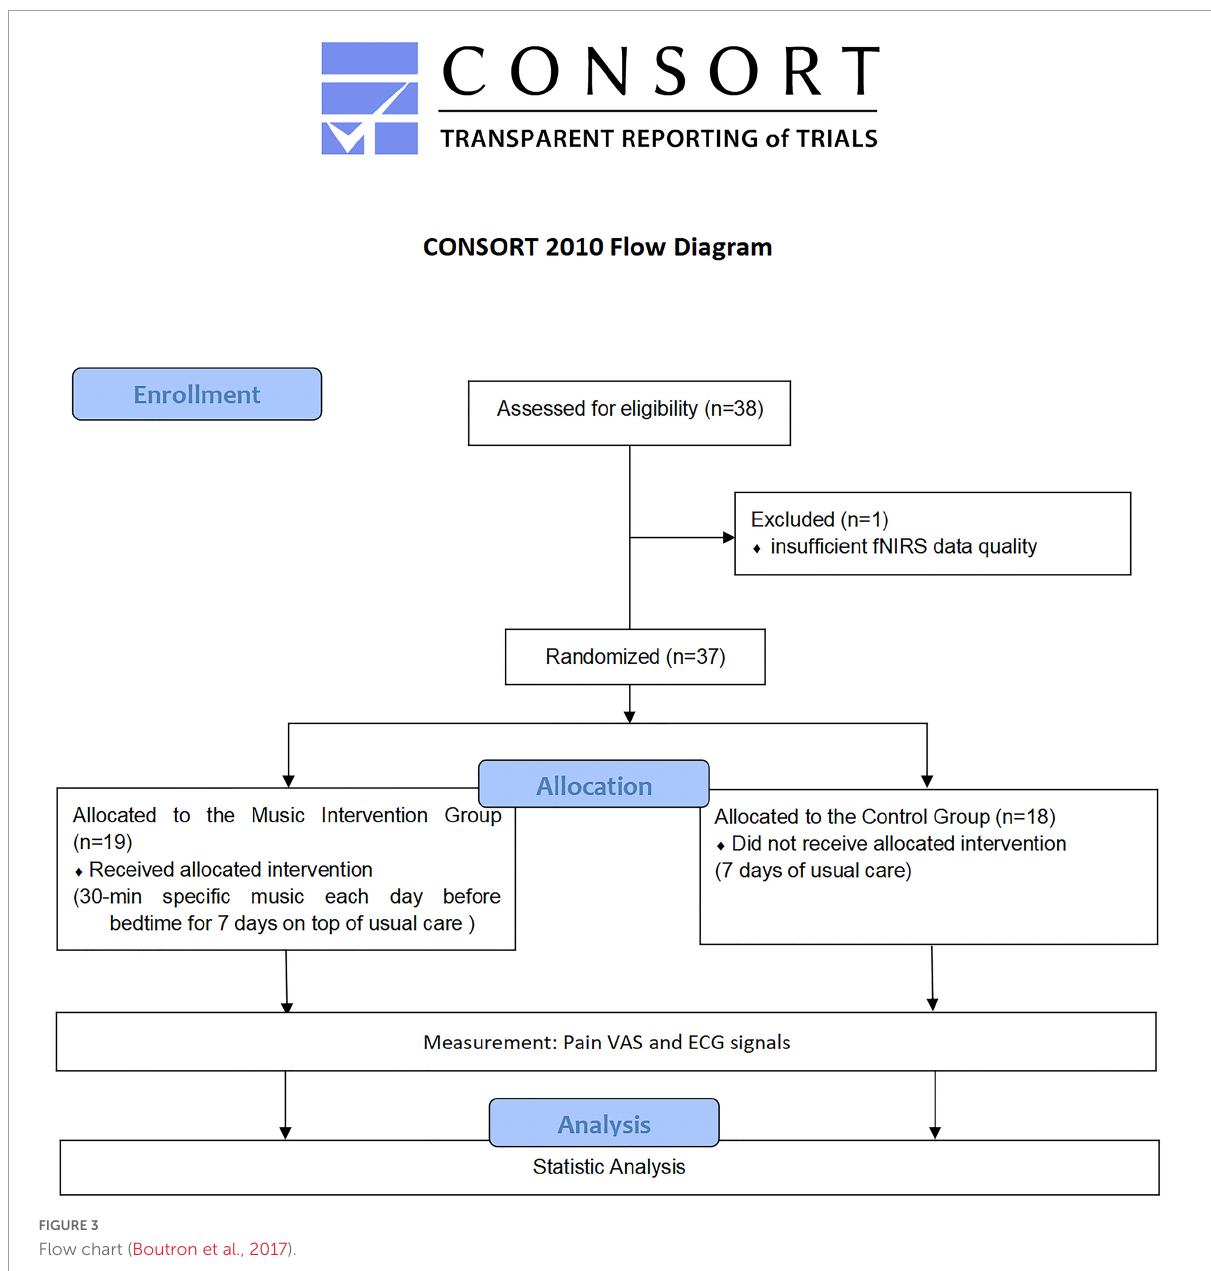
FIGURE3 Flow chart (Boutron et al.,